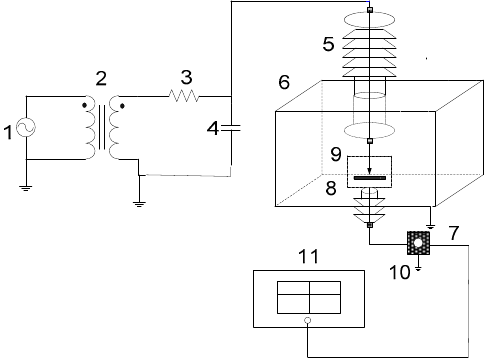
Figure 4. The sketch of electrical faults simulation setup. 1–AC power; 2–transformer; 3–protection resistance; 4–coupling capacitor; 5–high-voltage bushing; 6–tank; 7–ground wire; 8–ground bushing; 9–sample; 10–current sensor; and 11–oscilloscope.